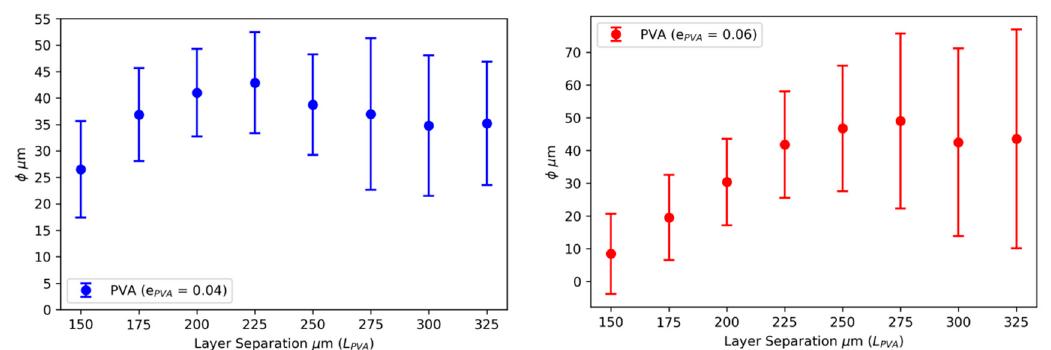
Figure 7. The variation of ϕ Layer 2 for PVA layers printed at e PVA = 0.04 ( left ) and 0.06 ( right ) for layer separations ( L PVA ) between 150 and 325 µ m. Values of ϕ are calculated from the sample thicknesses recorded in Figure 5.